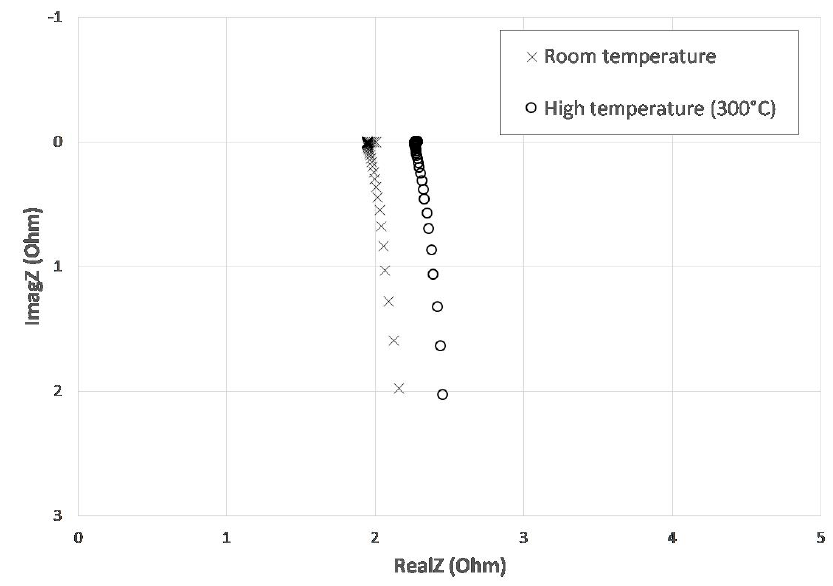
Figure 7. EIS results of the leads and potentiostat (Nyquist plot).